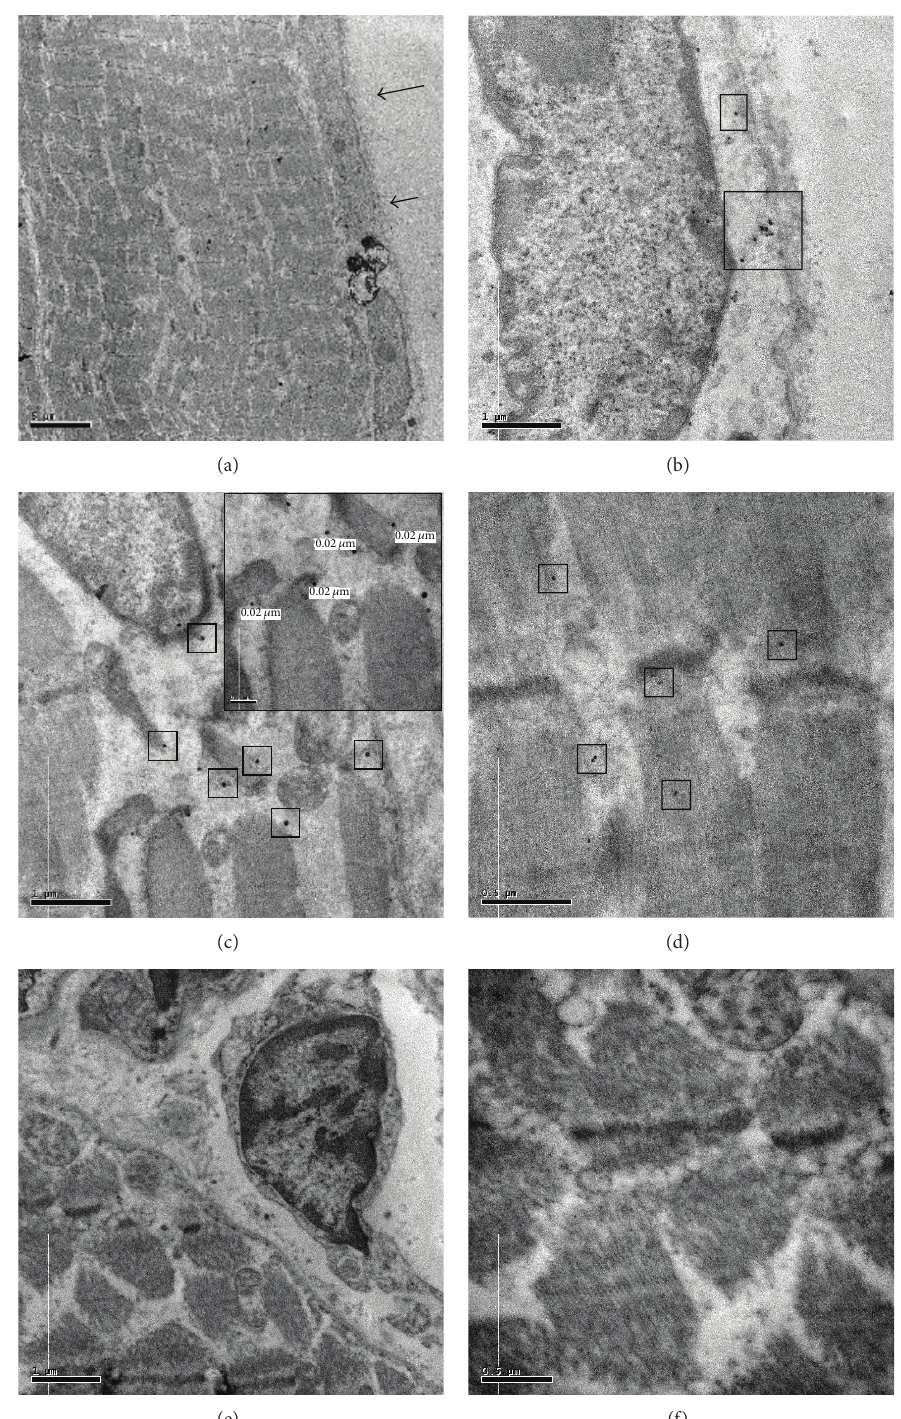
Figure 5: Molecular analysis of BMP-2 expression. In order to verify the correlation between BMP-2 and satellite cells activity we performed both western blot and immune-gold analysis. In muscle biopsies of OA patients we found several large satellite cells syncytium (arrows) (a). High magnifications show immunolabeling for BMP-2 in perinuclear areas (squares) (40.000x) (b). BMP-2 molecules were expressed in the satellite cells syncytium cytoplasm (squares) and next to mitochondria (insert) (40.000 and 60.000x) (c). Numerous BMP-2 molecules were found in the fiber body (40.000x) (d). OP patients do not express BMP-2 in satellite cells (10.000x and 40.000x)